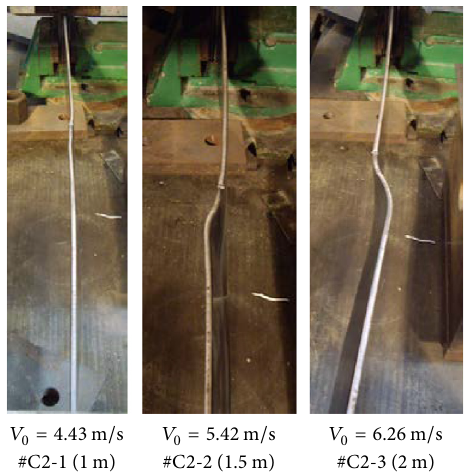
Figure 11: Deformation modes of #B3 (𝛼 = 14, 𝛽 = 20).